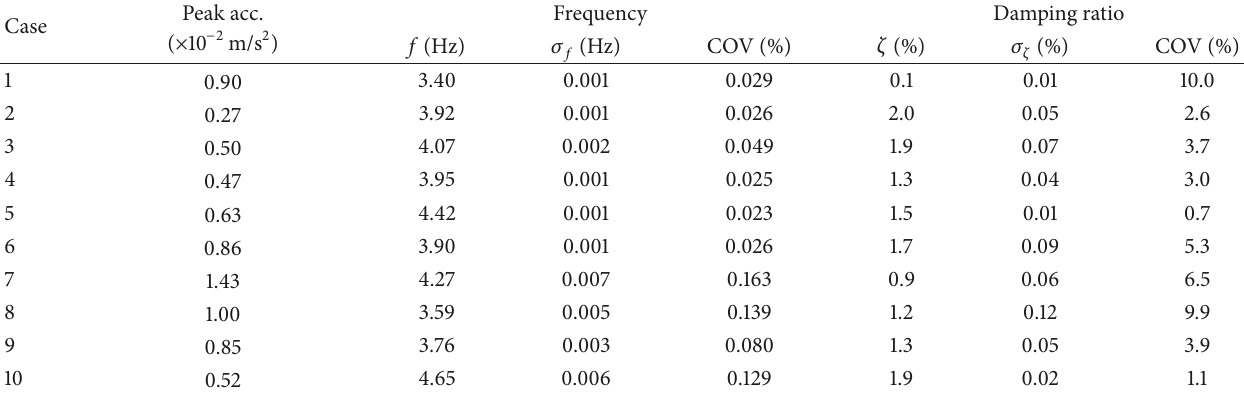
Table 3: Natural frequencies and damping ratios estimated from ambient vibration tests.